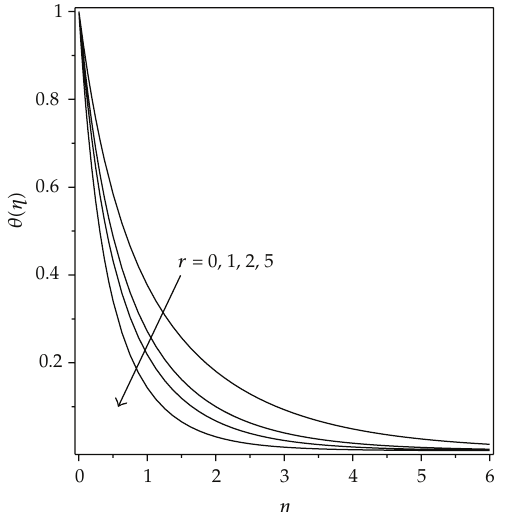
Figure 6: Temperature profiles for di ff erent values of r when Pr (cid:9) 0 . 78, Sc (cid:9) 0 . 6, D f (cid:9) 0 . 03, S r (cid:9) 2, M (cid:9) 1, and f 0 (cid:9)